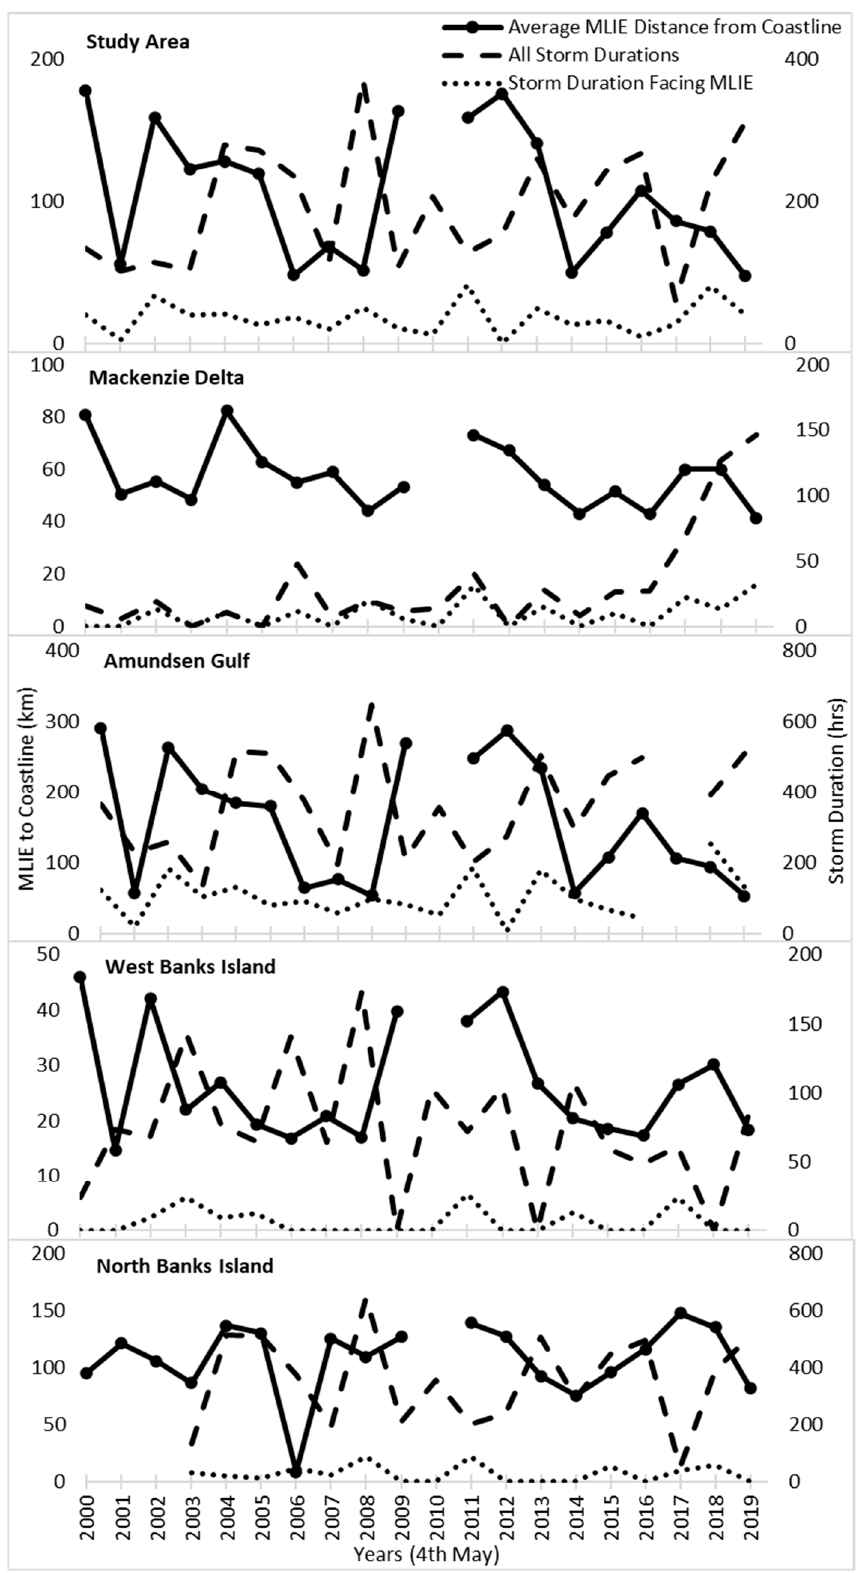
Figure 6. Average MLIE distance from the coastline, all storm duration, and storm duration facing the MLIE edge averaged for the preceding 3 months across the Northwest Canadian Arctic study area and each of the four regions from 2000 to 2019 is